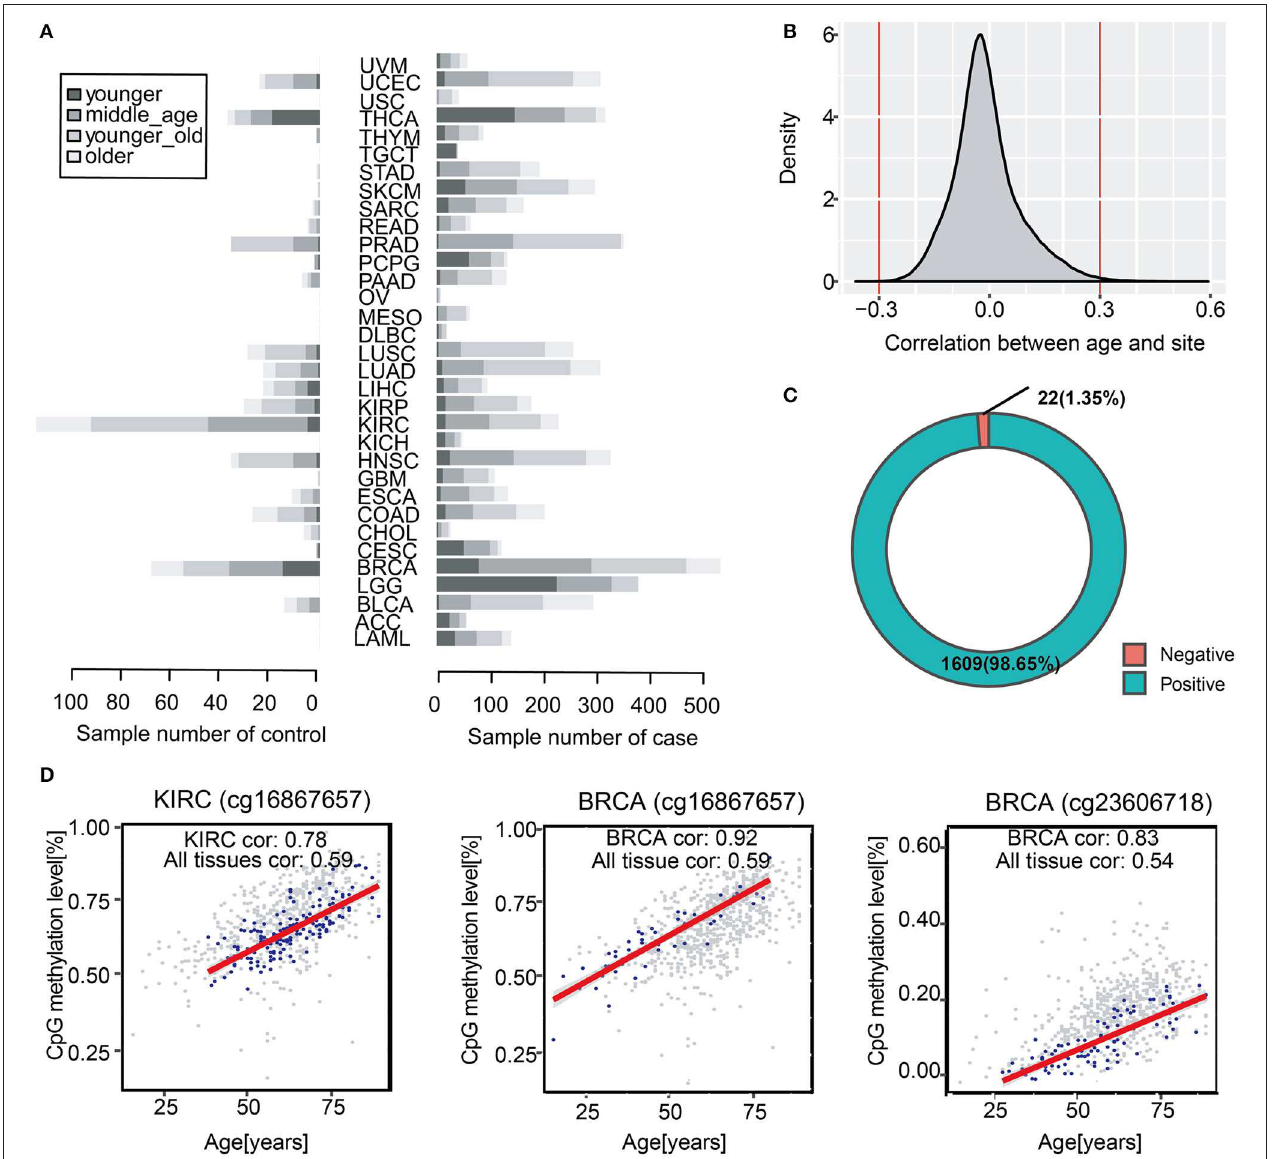
FIGURE 1 | Identification of chronological age-related DNA methylation sites in human normal tissues. (A) The barplot shows sample distribution of four age segments in diverse cancer types. The lighter color represents larger age of samples. (B) Distribution of correlation scores between all methylation sites and chronological age. (C) Spearman correlation between age and methylation ( P < 0.05, |cor| > 0.3). The pie chart shows the proportion of 1,631 positive and negative methylation sites correlated with chronological age. (D) The scatter diagram shows the correlation between methylation sites (cg16867657, cg23606718) and chronological age in KIRC and BRCA. The overall background is the methylation sites of all samples (gray color), and the blue color represents the correlation between chronological age and methylation age in a certain type of samples such as BRCA and